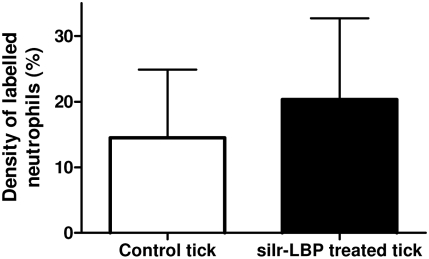
Density measurement of labeled neutrophils in skin of tick-infested mice.The light histogram represents the percentage of neutrophils per zone in skin sections of mice infested with control ticks (n = 55). The dark histogram represents the percentage of neutrophils per zone in skin sections of mice infested with ticks treated with Ir-LBP siRNA (n = 35, **: p<0.05).